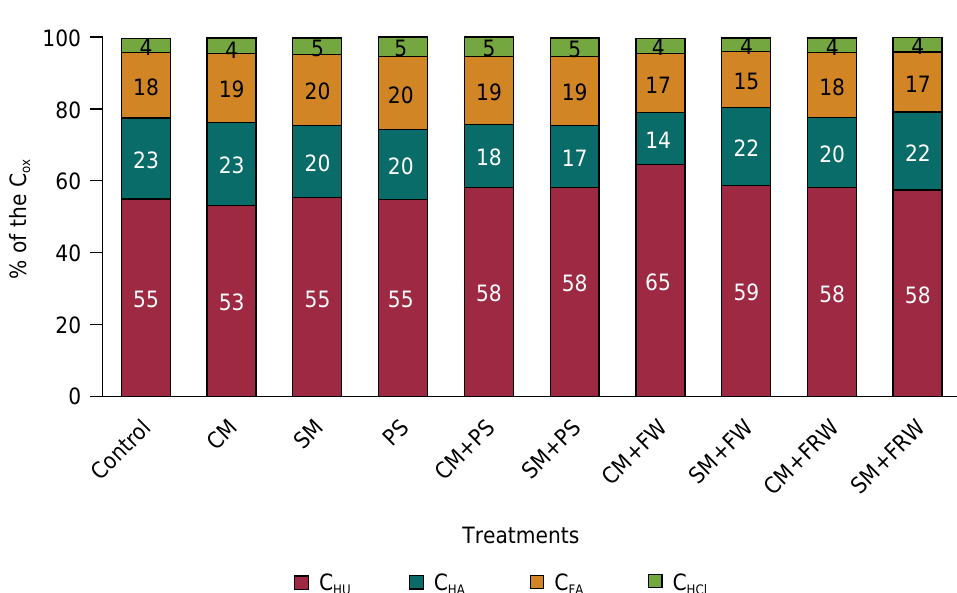
Figure 1. Contribution (%) of the carbon content as humin (C HU ), humic acid (C HA ), fulvic acid (C FA ), and acid extract (C HCl ) to the oxidizable carbon (C ox ) content of an Acrisol amended with vermicomposts. (1) Treatments: Control = without vermicompost; CM = cattle manure; SM = sheep manure; PS = rice parboiling sludge; CM+PS = cattle manure + rice parboiling sludge; SM+PS = sheep manure + rice parboiling sludge; CM+FW = cattle manure + food waste; SM+FW = sheep manure + food waste; CM+FRW = cattle manure + fruit waste; and SM+FRW = sheep manure + fruit waste. Mixture of vermicomposts was performed in 1 : 1